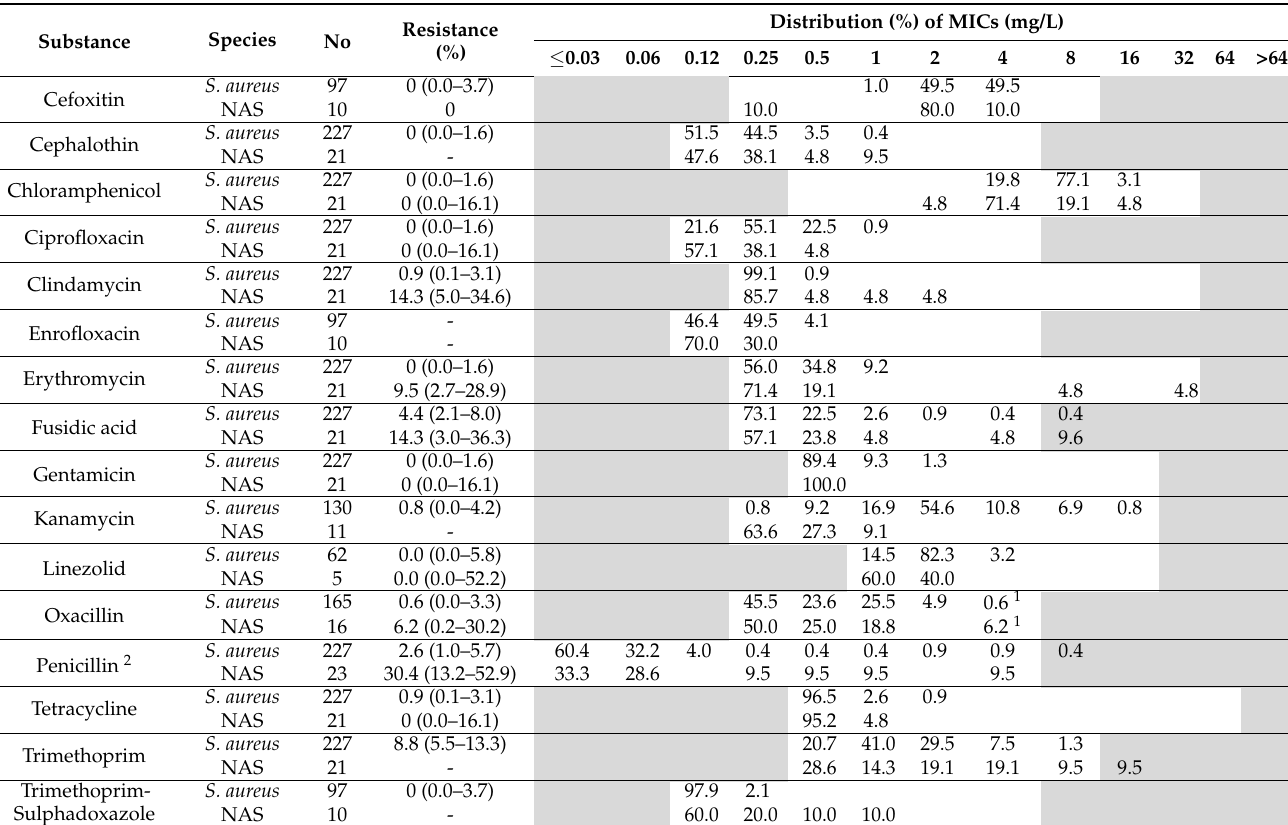
Table 2. Number of isolates (No), resistance (per cent, 95% CI in brackets), and MIC distribution (%) for Staphylococcus aureus ( n = 227) and non- aureus staphylococci (NAS) ( n = 21) from clinical mastitis in dairy cows. White fields indicate test range for each